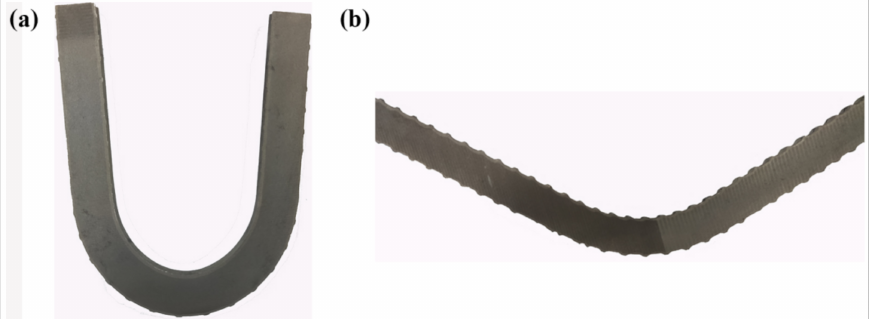
Figure 16. Shape of the bent specimen post-cut: ( a ) forward-bent shape; ( b ) reverse-bent shape.